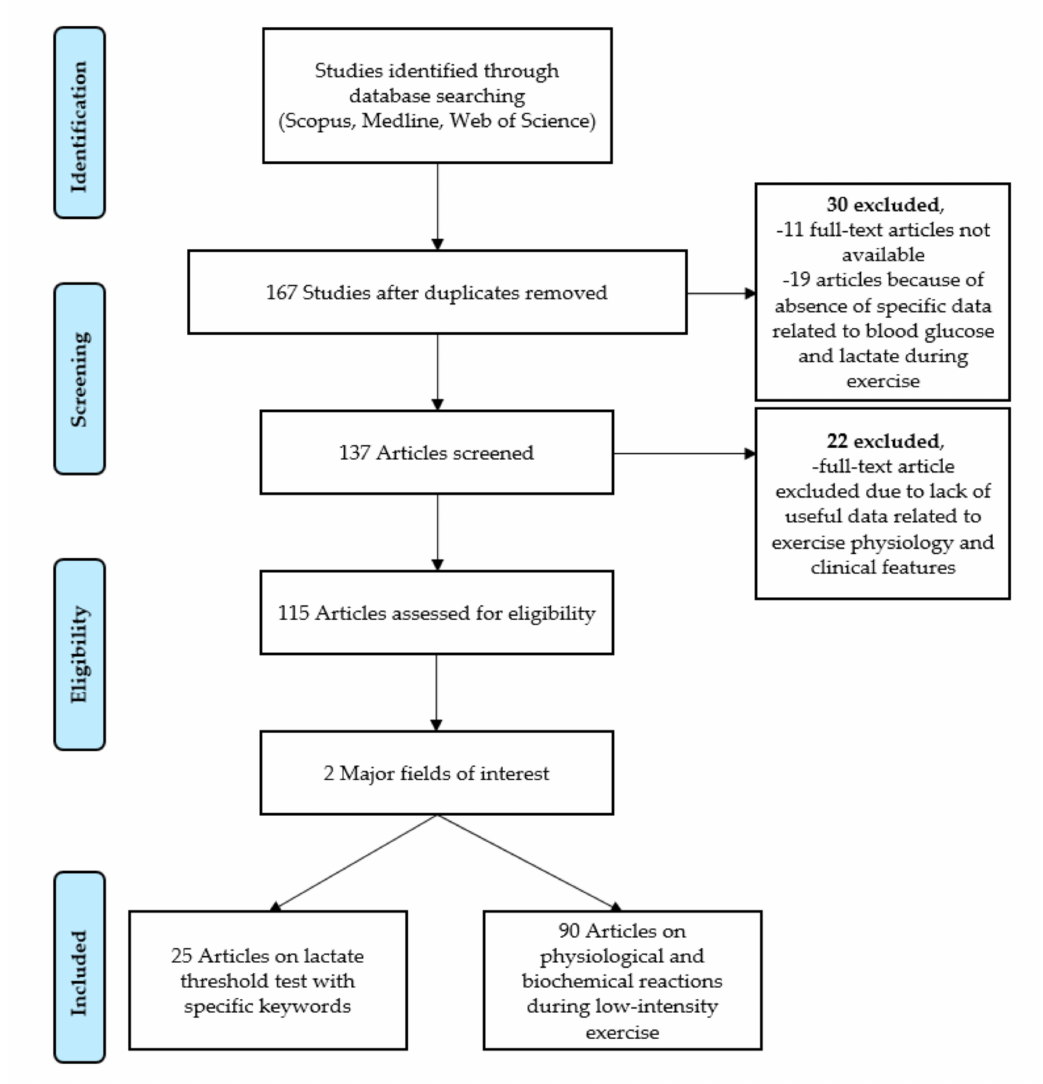
Figure 1. Flow chart outlining the literature search